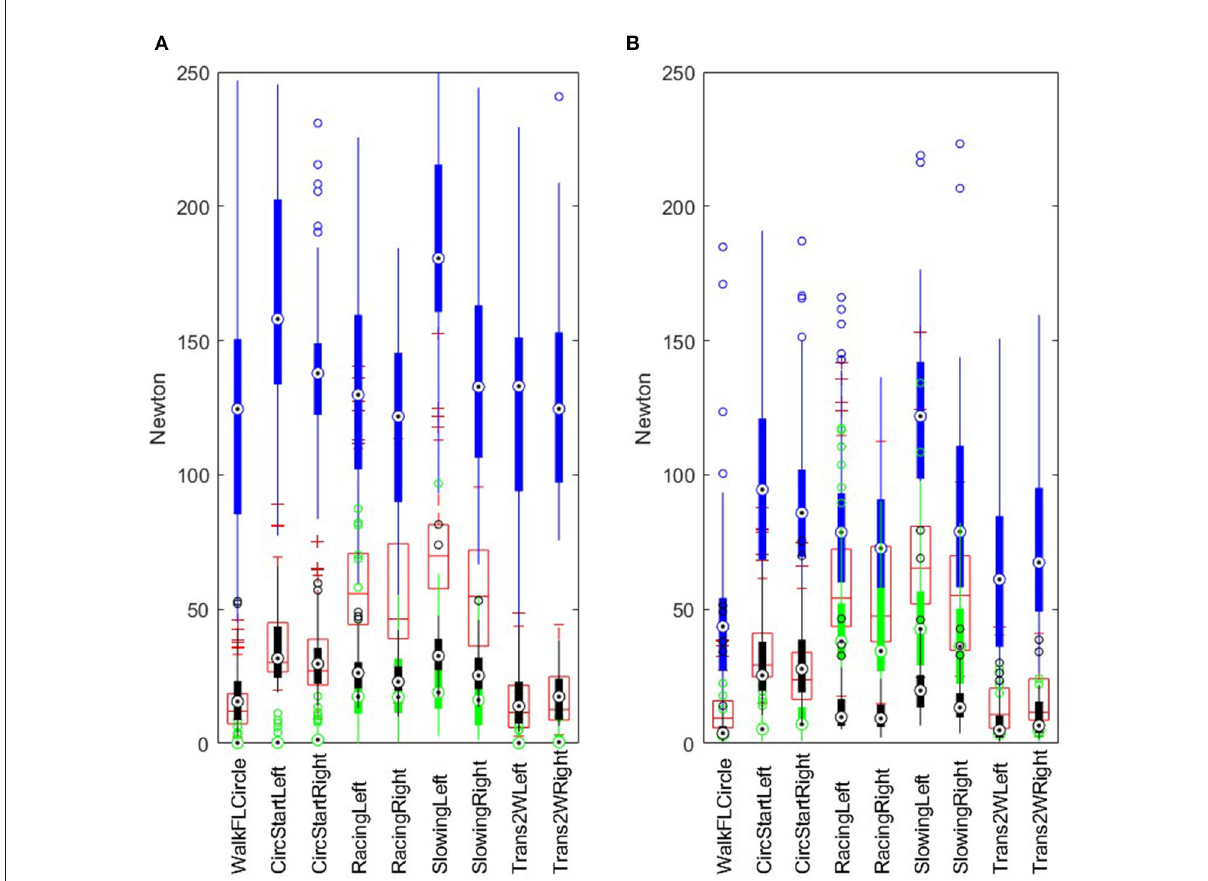
FIGURE3 Boxplot of segment minimum (green), median (red), maximum (blue) and interquartile range (black) for raw (A) and filtered (B) rein tension, including data for both left and right reins. Data from 26 horse-driver combinations ( n = 26 or 25 for each segment, as there was partial data loss for one measurement). For explanation of segment acronyms, see Table